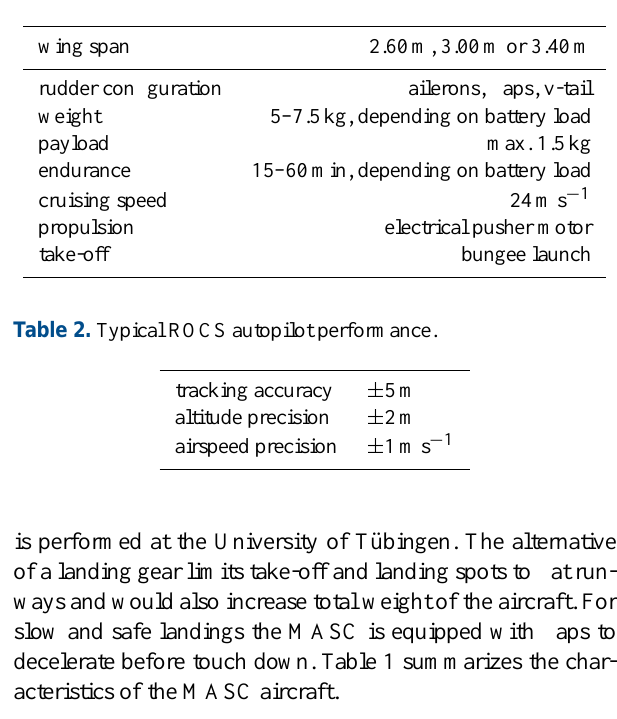
Table 1. Characteristics of the MASC RPA.